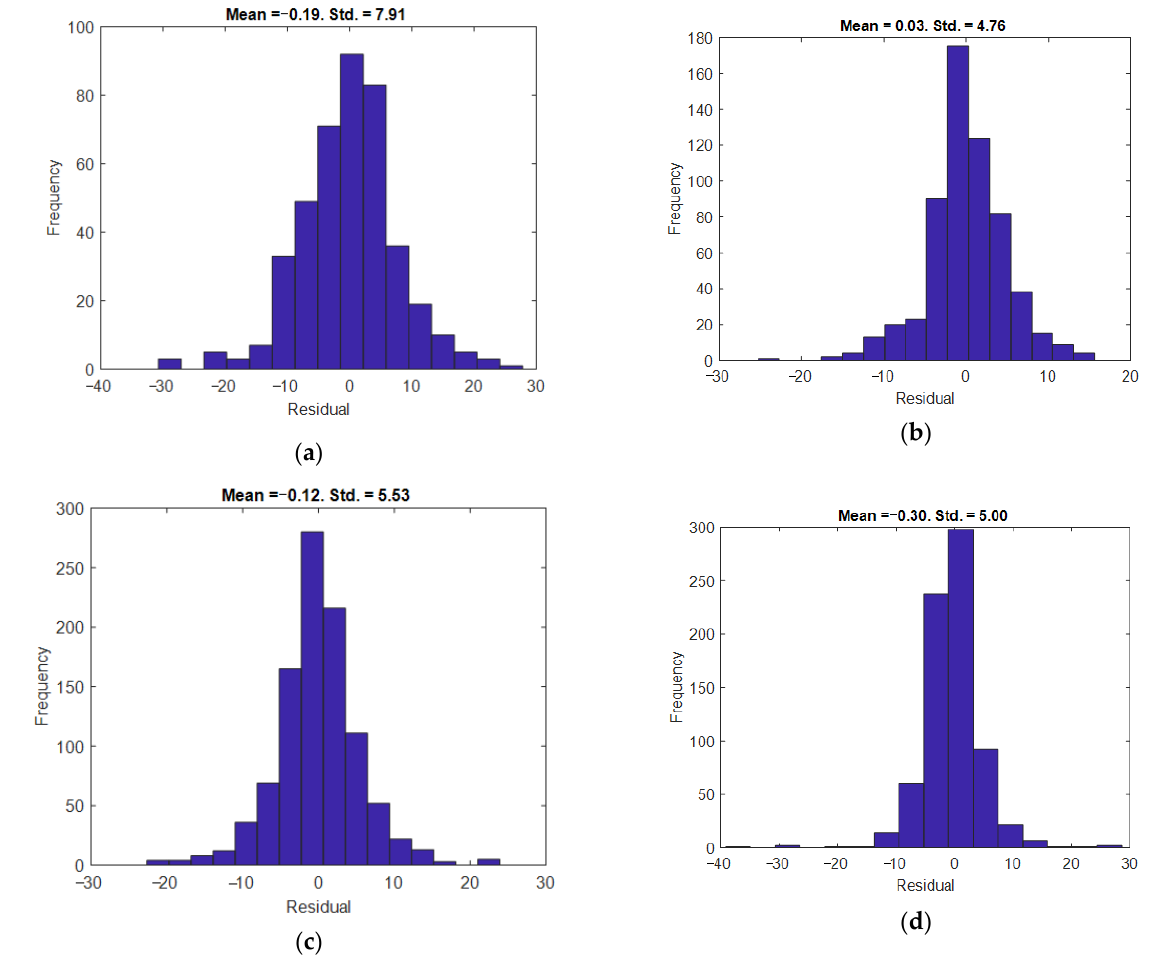
Figure 7. Histograms of residuals of the ML models used for predicting the CS: ( a ) Dataset 1, ( b ) Dataset 2, ( c ) Dataset 3, and ( d ) Dataset 4. Table 8. Average computational time (s).